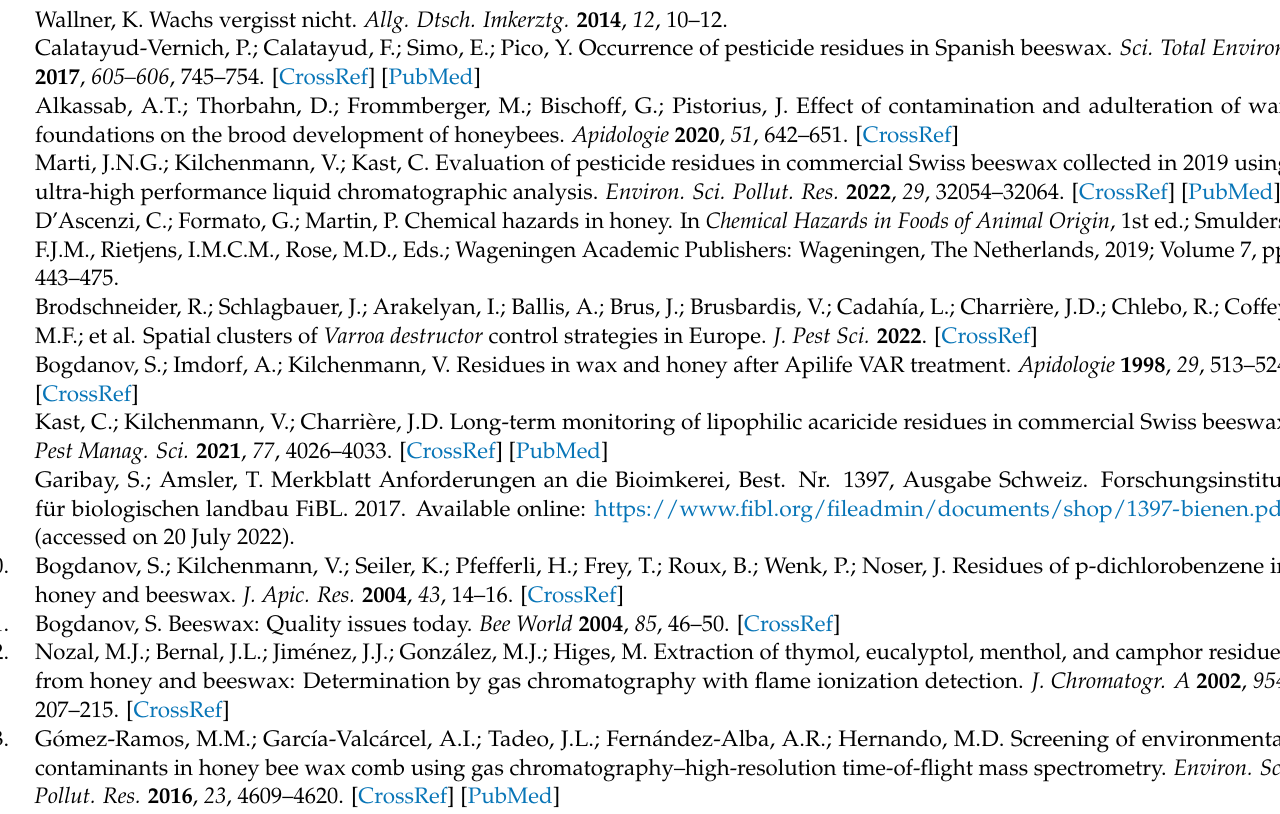
Figure A2 . Chromatogram (SIM mode) of thymol in beeswax. Quantitation ion m/z 135 and quali- Figure A2. Chromatogram (SIM mode) of thymol in beeswax. Quantitation ion m/z 135 and tative ions m/z 150 and 91. qualitative ions m/z 150 and